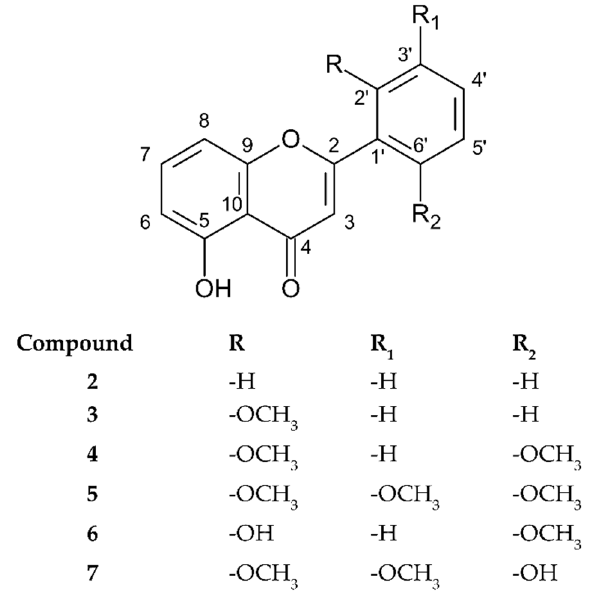
Figure 3. Chemical structures of compounds 2–7 .